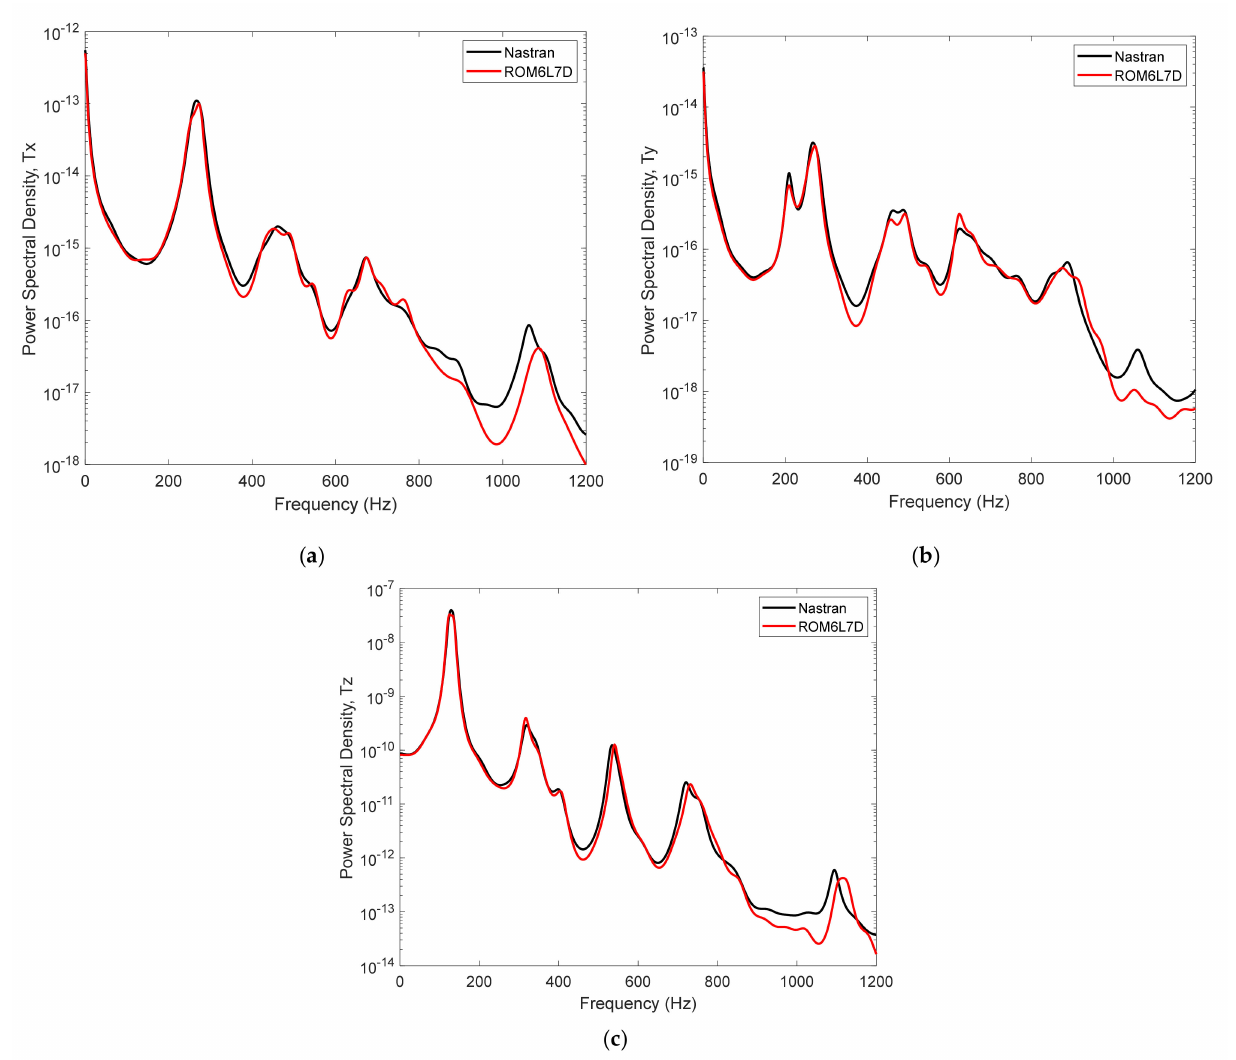
Figure 6. Power spectral densities of the responses predicted by Nastran and the ROM. Freely expanding plate under an excitation of OASPL = 147 dB. ( a , b ) In-plane x and y displacements of the bottom left corner, ( c ) transverse displacement of panel